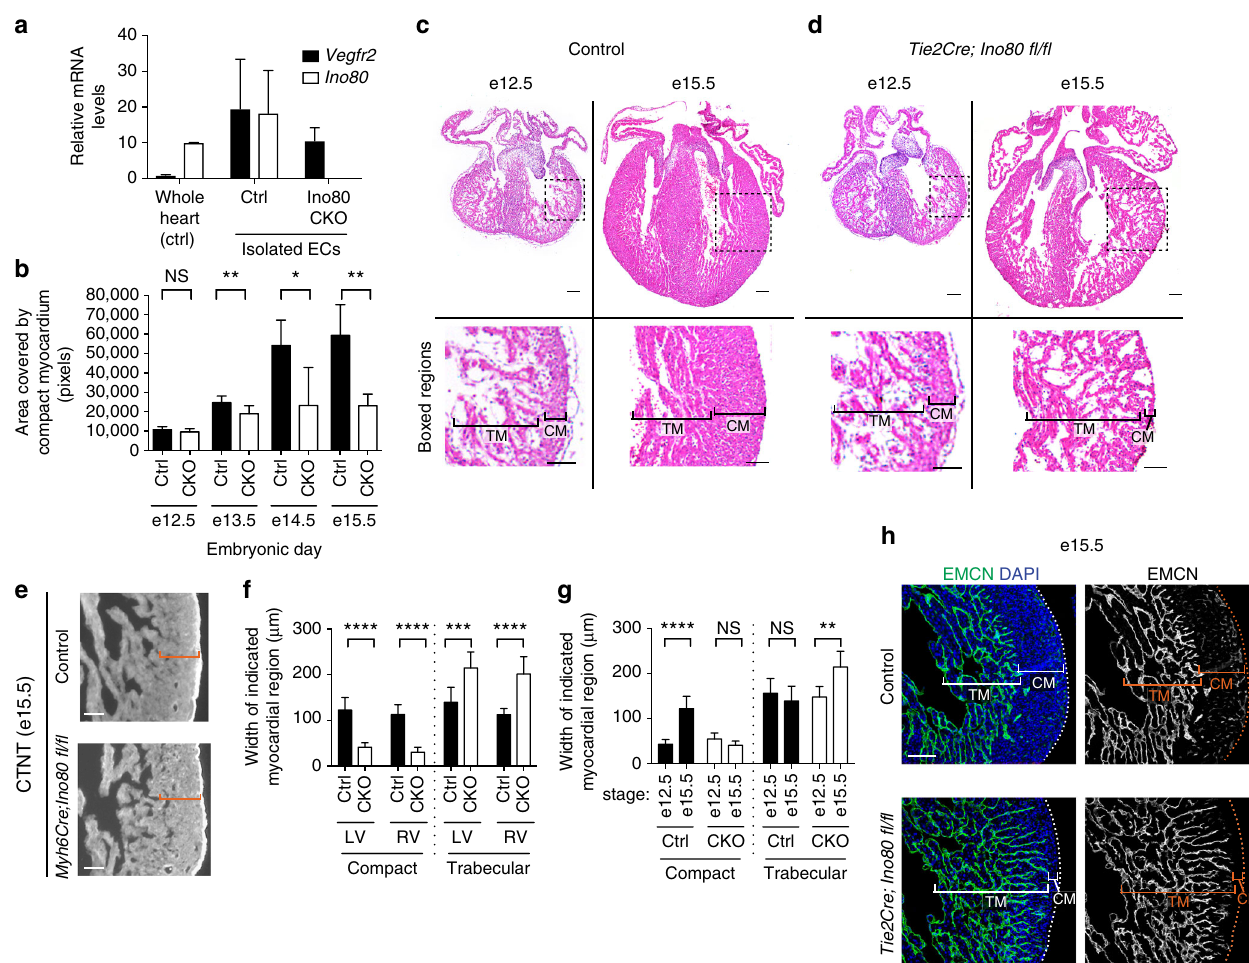
Fig. 1 Compact myocardium development is disrupted with endothelial-speci fi c knockout of Ino80 . a Quantitative PCR analysis of endothelial cells (ECs) isolated from control (Ctrl) and Tie2Cre;Ino80 fl / fl (CKO) hearts reveal that Vegfr2 is expressed while Ino80 mRNA is undetectable. Error bars in graphs are standard deviation. (control, n = 3 hearts; mutant, n = 3 hearts). b Measurements of the area covered by compact myocardium in tissue sections from control or Tie2Cre;Ino80 fl / fl hearts at the indicated embryonic stages. NS nonsigni fi cant, * P < 0.05; ** P < 0.01, evaluated by Student ’ s t -test. c , d Tissue sections stained with Hematoxylin and Eosin show trabecular myocardium (TM) and compact myocardium (CM) in control ( c ) and CKO hearts ( d ). Images are representative of the following number of replicates: control, n = 6 hearts; mutant, n = 5 hearts at e12.5, control, n = 9 hearts; mutant, n = 6 hearts at e15.5. Scale bars: 100 μ m. e Compact myocardium (orange brackets) is not thin with myocardial-speci fi c deletion of Ino80 ( Myh6Cre;Ino80 fl / fl ) . Images are representative of the following number of replicates: control, n = 6 hearts; mutant, n = 5 hearts. Scale bars: 100 μ m. f Trabecular myocardium thickness is increased in the left and right ventricles in Ino80 CKOs. Error bars in graphs are sd. (control, n = 6 hearts; mutant, n = 5 hearts at e12.5, control, n = 9 hearts; mutant, n = 6 hearts at e15.5). *** P < 0.001; **** P < 0.0001, evaluated by Student ’ s t -test. g The normal growth in compact layer thickness from e12.5 to 15.5 is replaced by an abnormal expansion of the trabecular layer in mutant hearts. Error bars in graphs are standard deviation. (control, n = 6 hearts; mutant, n = 5 hearts at e12.5, control, n = 9 hearts; mutant, n = 6 hearts at e15.5). NS nonsigni fi cant, ** P < 0.01; **** P < 0.0001, evaluated by Student ’ s t -test. h Endomucin (EMCN) immuno fl uorescence to label endocardium shows an expansion of this cell type into the area occupied by compact myocardium in control hearts. Images are representative of the following number of replicates: n = 9 hearts; mutant, n = 6 hearts at e15.5. Scale bars: 100 μ layer markers (Hey2, Tbx20, and N-myc) and a trabecular marker protein, Myomesin, revealed that highly structured sarcomeres (Cx40). This analysis revealed that the myocardium with were normally restricted to the CX40 + trabecular myocardium at e15.5. However, the trabecular-like Myomesin pattern was also trabecular morphology (loosely packed, endocardial-lined), which present in the CX40-negative abnormal intermediate myocar- was adjacent to the thin compact layer of Ino80 mutants, dium in non-compacted Tie2Cre;Ino80 fl / fl hearts (Fig. 2e). Taken expressed the compact markers Hey2, Tbx20, and N-myc and together, these disruptions in heart wall patterning indicate that lacked the trabecular marker, Cx40 (Fig. 2c). This was seen in Ino80 mutant mice exhibit ventricular non-compaction. both the left and right ventricles. The presence of myocardium with compact identity, but trabecular morphology is reminiscence of the “ intermediate myocardium ” previously described for non- compacted hearts lacking components of the NOTCH signaling Speci fi c deletion in the endocardium and sinus venosus . In the pathway 10 . Intermediate myocardium is schematized in Fig. 2d previously described experiments, Ino80 was deleted from all and labeled in Fig. 2c, e. Immuno fl uorescence for the sarcomeric endothelial cell types within the heart. We next investigated | DOI: 10.1038/s41467-017-02796-3 |